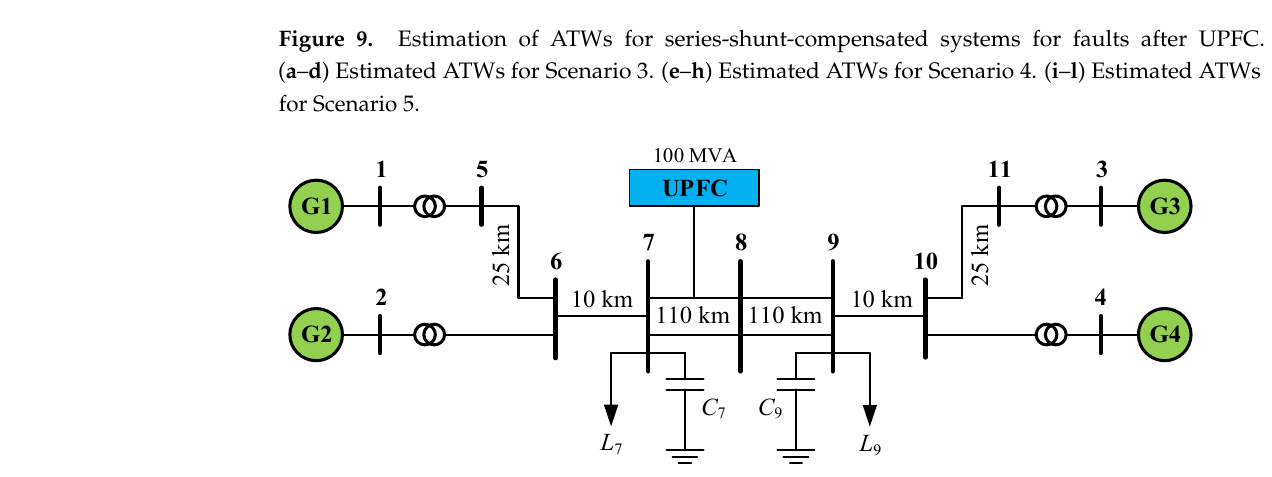
Figure 10. Single line diagram of two-area four-machine Kundur 11-bus test system. Table 4. Performance under series-shunt compensation in two-area four-machine Kundur 11-bus test